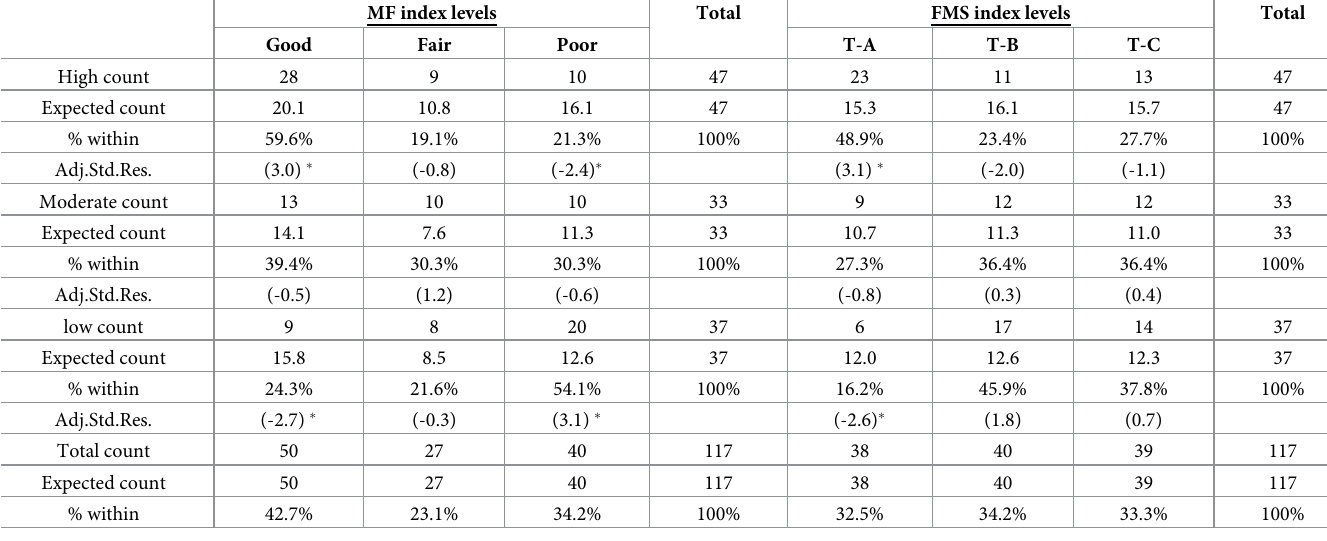
Table 6. Chi-Square Cross-Tabulations indexes for FMS ™ levels × MF levels and FMS ™ levels × FMS